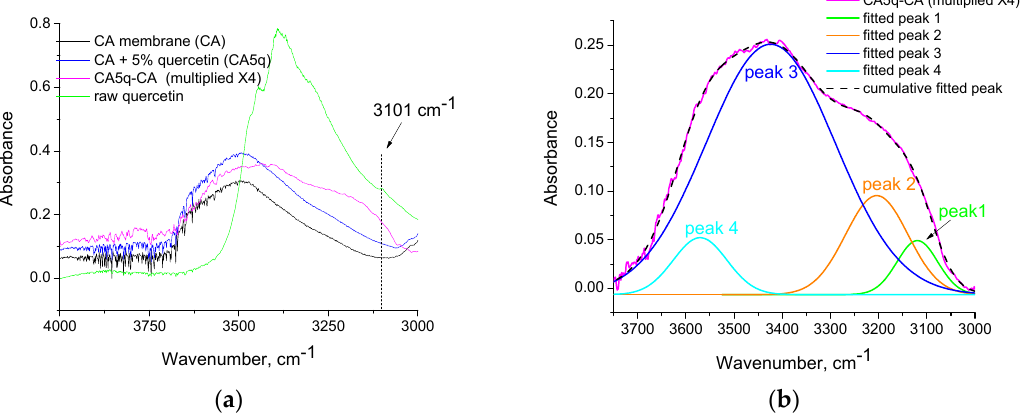
Figure 6. ( a ) FTIR spectra of CA membrane (CA), CA-5% quercetin (CA5q), their subtracted spectrum (CA5q-CA) and raw quercetin in the region 2500–4000 cm − 1 . ( b ) Curve fitting of the positive peak of the subtracted spectrum occurring in the region 3000–3750 cm − 1 .